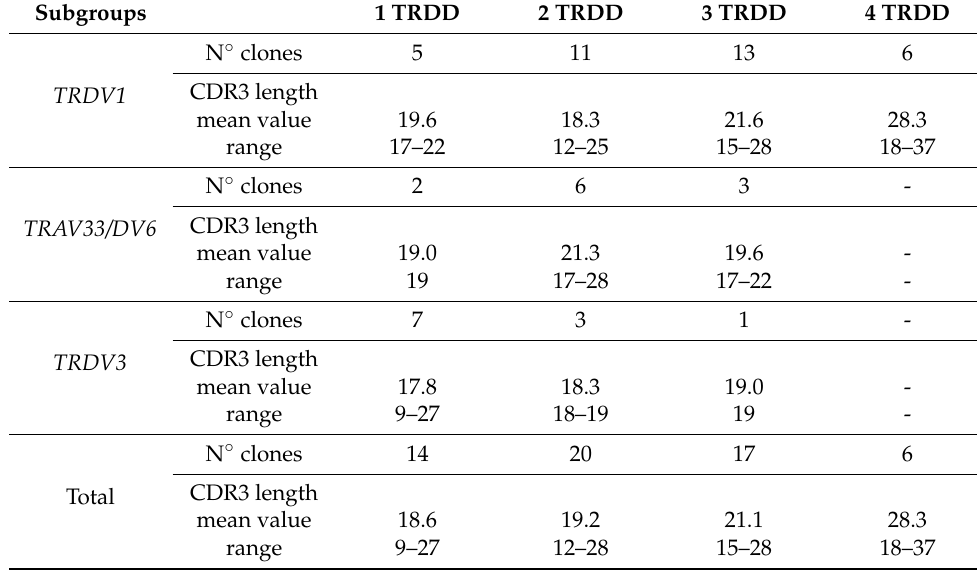
Table 4. Correlation between the CDR3 length (AA) and the number of TRDD